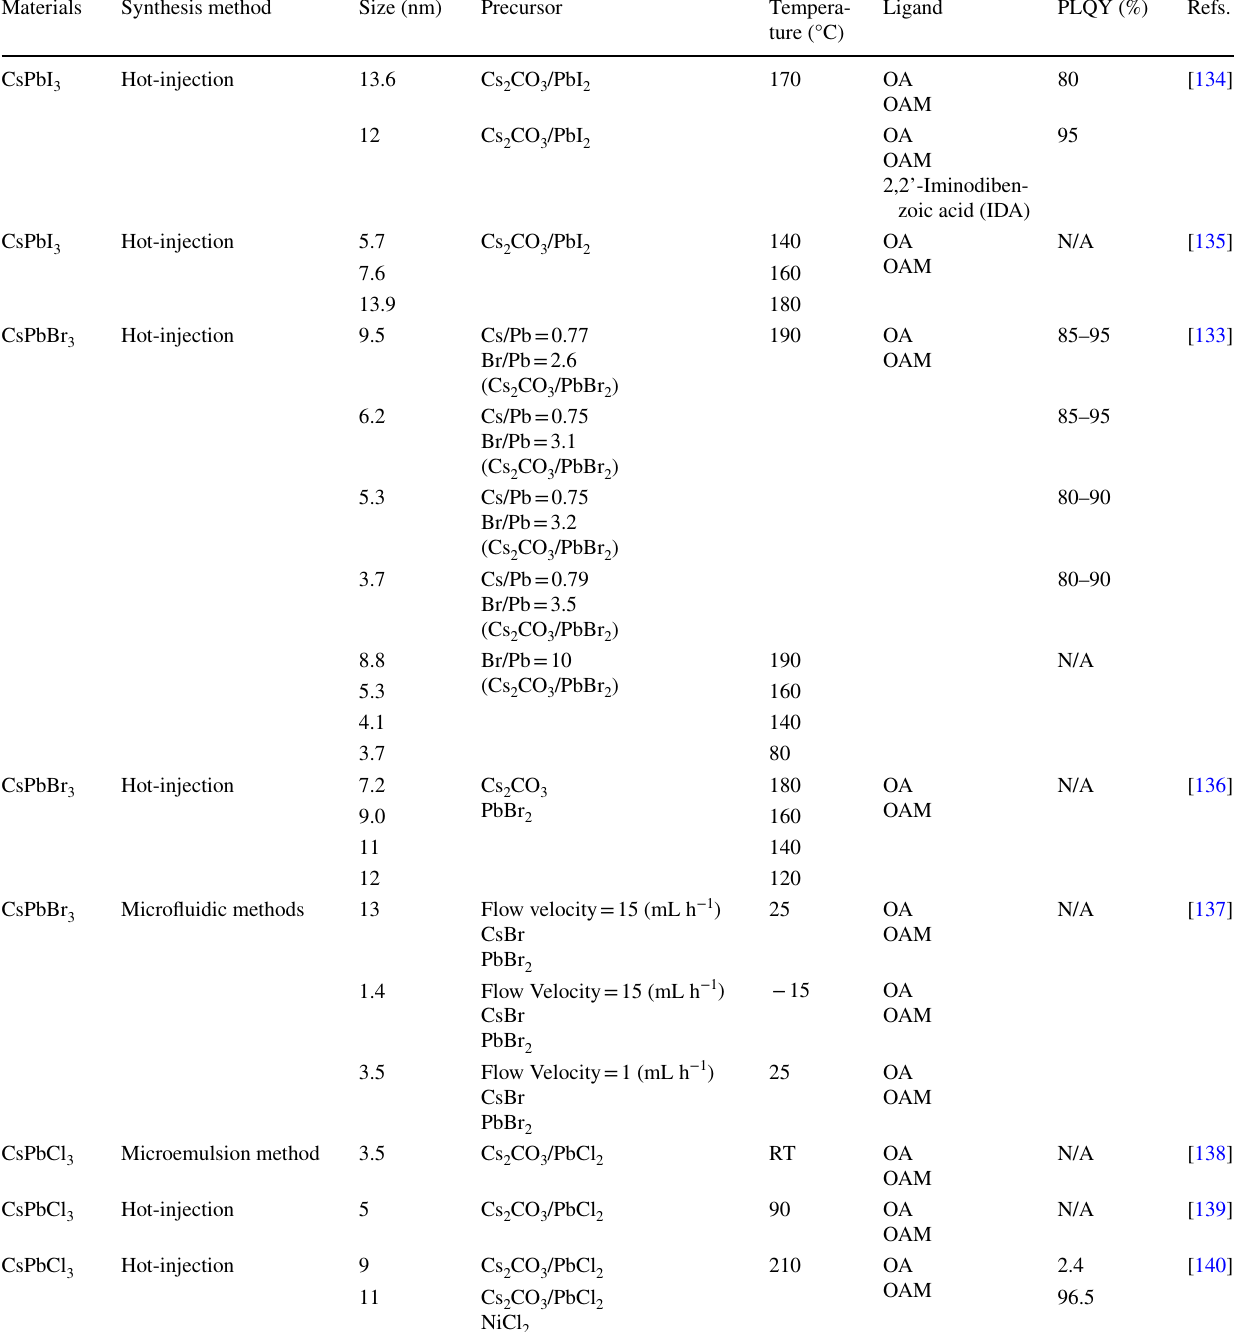
Table 1 Summary of some representative works on size control of inorganic perovskite QDs Materials Synthesis